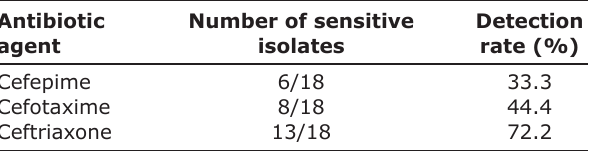
Table-5: Results of studying Escherichia coli isolates for ESBL phenotypic activities.